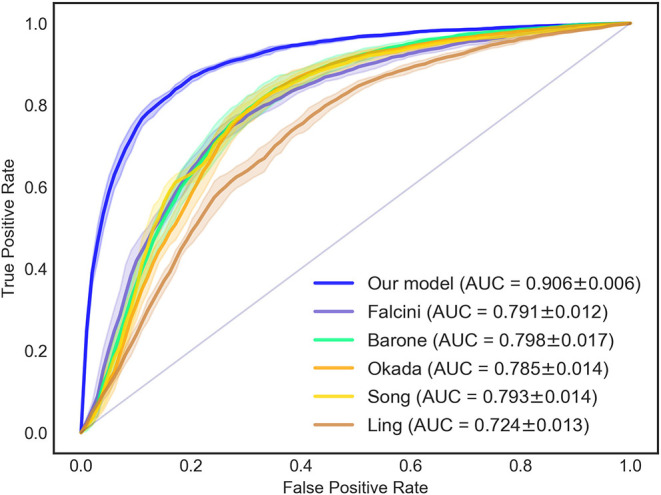
ROC and AUC of the diagnostic models for KD diagnosis. The AUC of the new KD diagnostic prediction model was 0.906 ± 0.006. Compared with previous KD diagnosis studies, the AUC value of the new model was higher than the methods of Falcini (0.791 ± 0.012), Barone (0.798 ± 0.017), Okada (0.785 ± 0.014), Song (0.793 ± 0.014), and Ling (0.724 ± 0.013). ROC, receiver-operator characteristic curves; AUC, area under the curve.